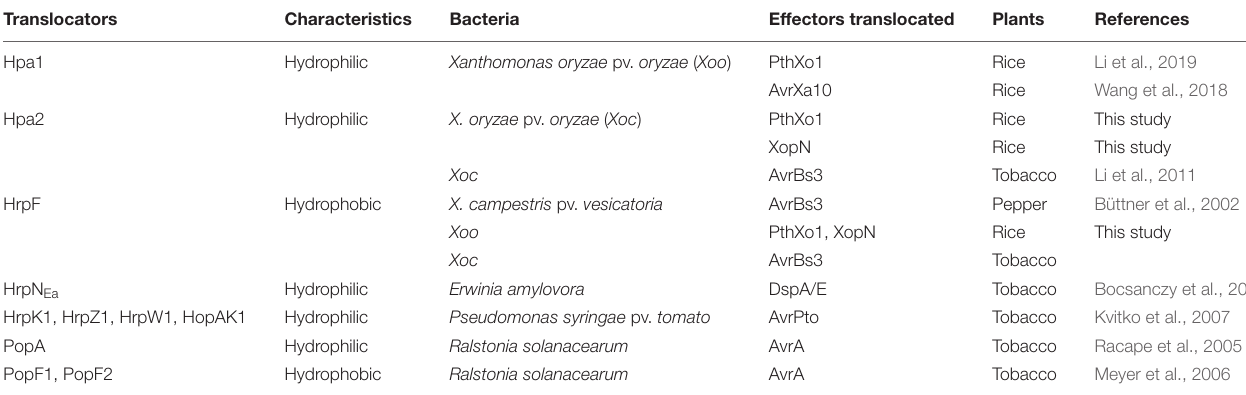
TABLE 1 | T3 translocators identified to date in plant-pathogenic